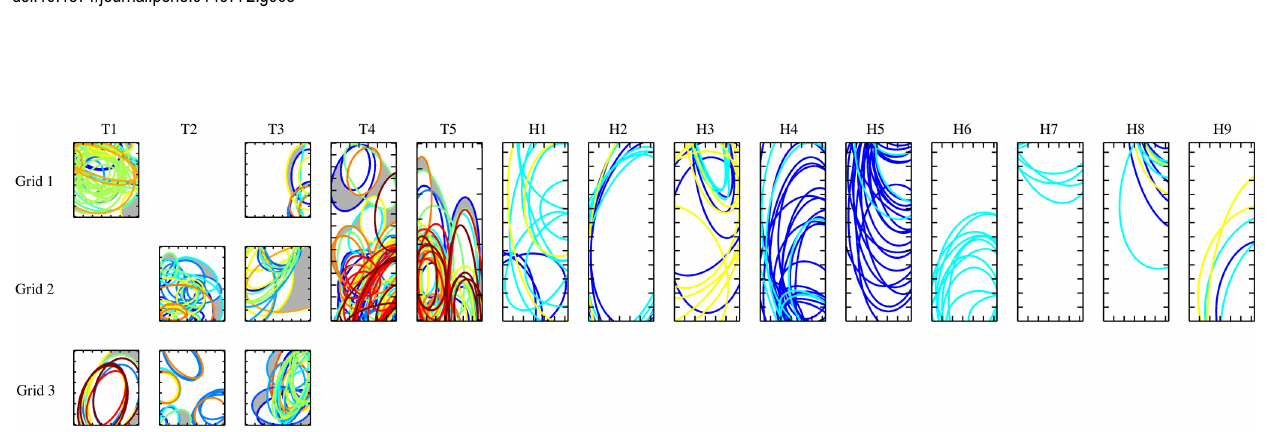
Fig 6. Spatial positions of the motor unit surface areas in each electrode grid (rows) for each subject (columns). Note that for this study, grid 1 for subject T2 and grid 2 for subject T1 were not used, since they were not covering the m . pectoralis . Surface areas with the same colour in a given grid correspond to motor units identified in the same movement. For able-bodied subjects, one colour represents the same contraction for each subject and for TMR patients the movement classes are different for each individual. The area on the grid occupied by motor units active during only one task is coloured in grey. The tick marks on the image borders denote 1 cm.